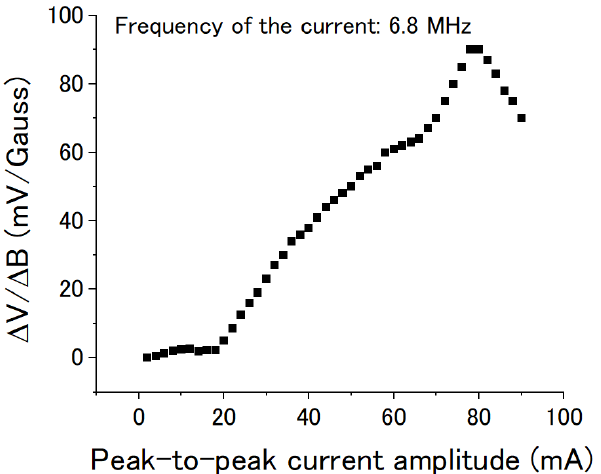
Figure 8. Voltage/field transfer coefficient ∆ V/ ∆ B of the coil vs the peak-to-peak amplitude of the sine wave current. The frequency of the current was kept at 6.8 MHz.